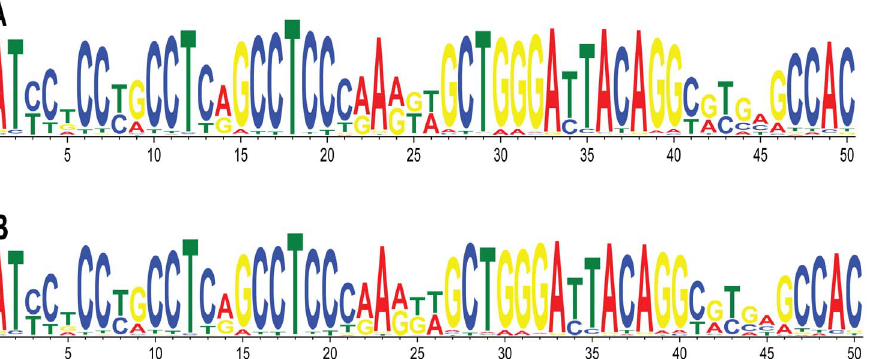
Figure 1. Common 50-bp motif in CNV breakpoint dataset. Logo plots for ( A ) MEME and ( B ) NestedMICA motifs show nearly identical consensus sequences.